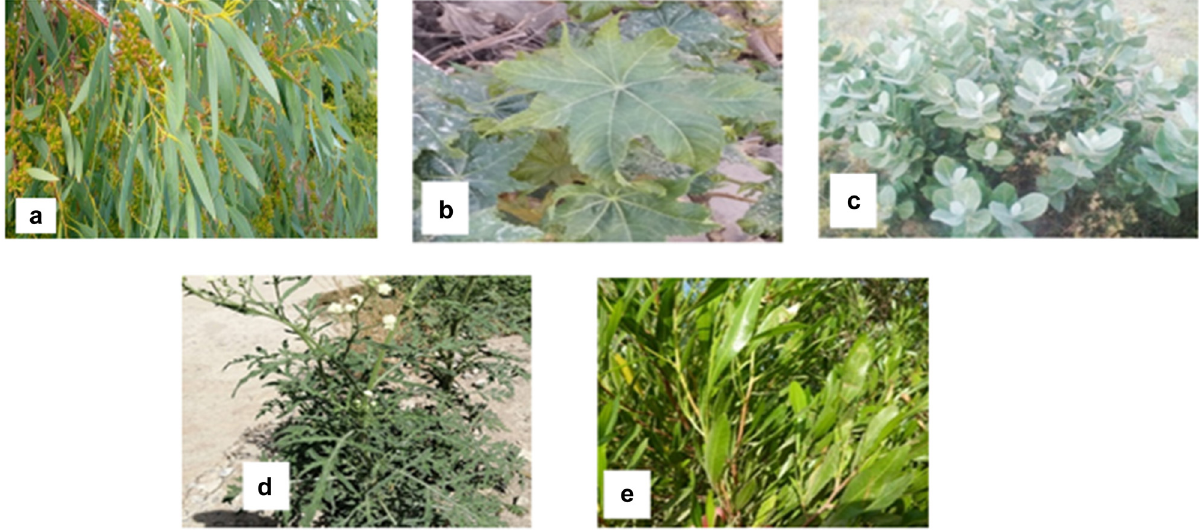
Figure 1: Medicinal plants used in the preparation of crude methanolic extract: ( a ) E. obliqua , ( b ) D. stramonium , ( c ) C. procera , ( d ) P. hysterophorus , and ( e ) D. viscosa